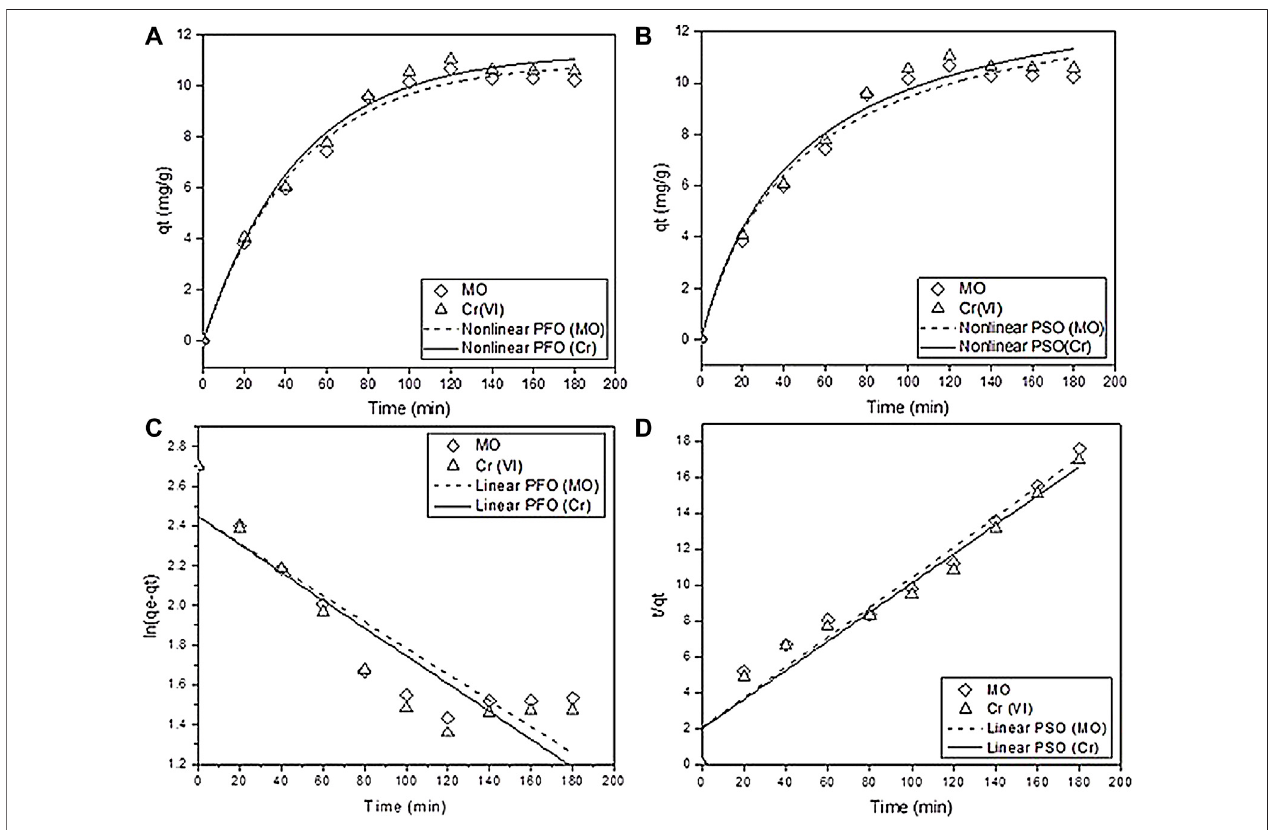
FIGURE 7 | Kinetic adsorption models. (A) NLPFO, (B) NLPSO, (C) LPFO, and (D) LPSO.